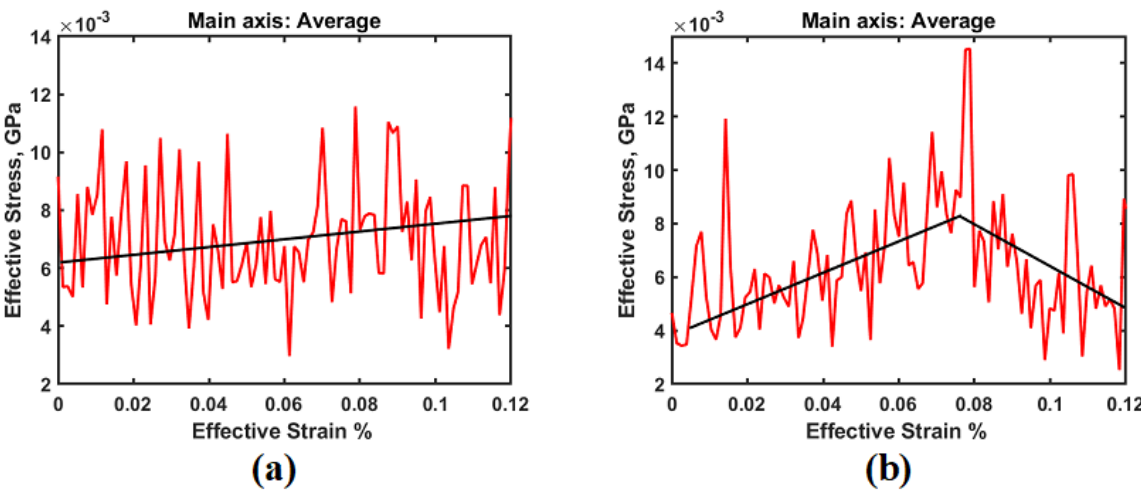
Figure 4. ( a ) Stress vs. strain for PE alone 3. ( b ) Stress vs. strain for PE-wax (45.2 wt%).